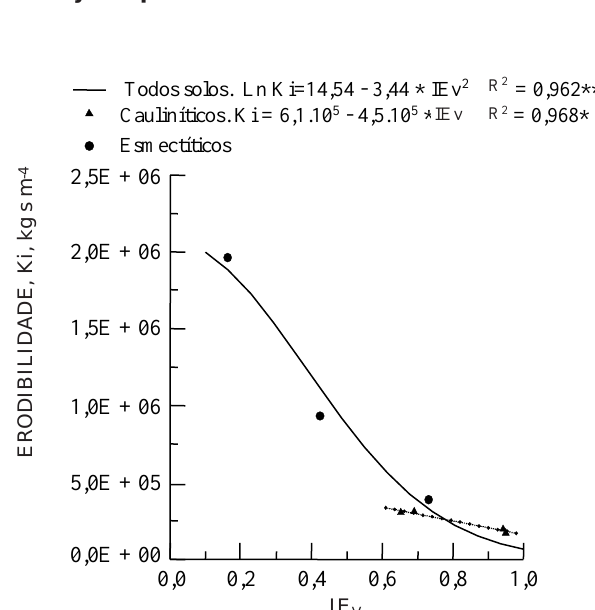
Figura 2. Relação entre a erodibilidade do solo em entressulcos e índice de estabilidade de Tisdall et al. (1978) em amostras de solos do Rio Grande do Sul. A reta (pontilhada) indica o ajuste para os solos cauliníticos.